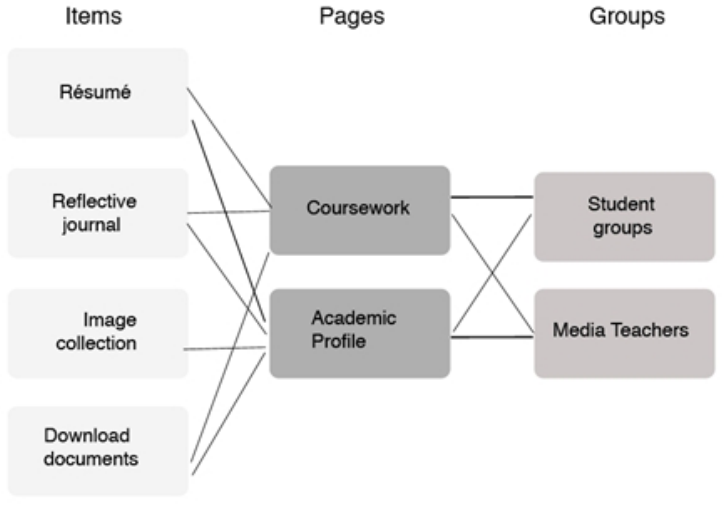
Figure 1. Organizing a portfolio: